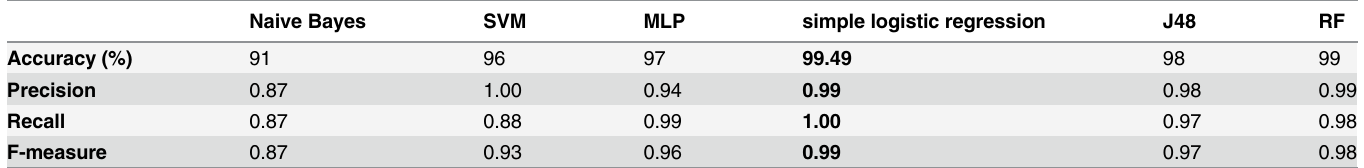
Table 5. Overall Accuracy and Precision for Drebin dataset